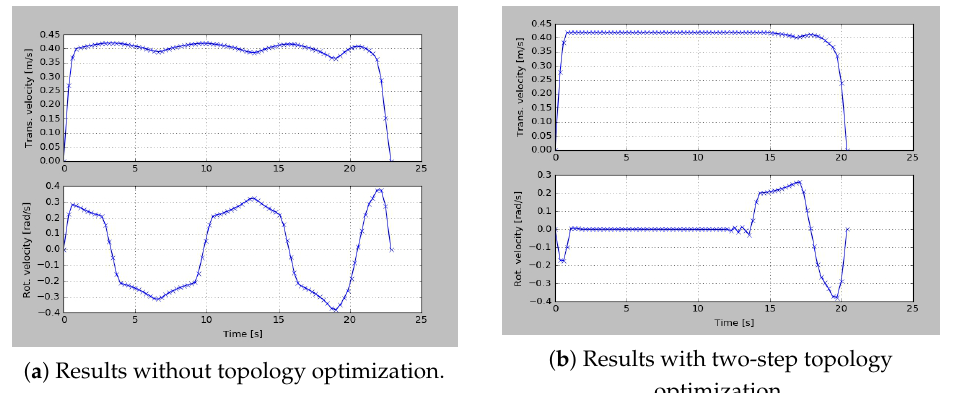
Figure 12. Linear velocity and angular velocity results of the optimal